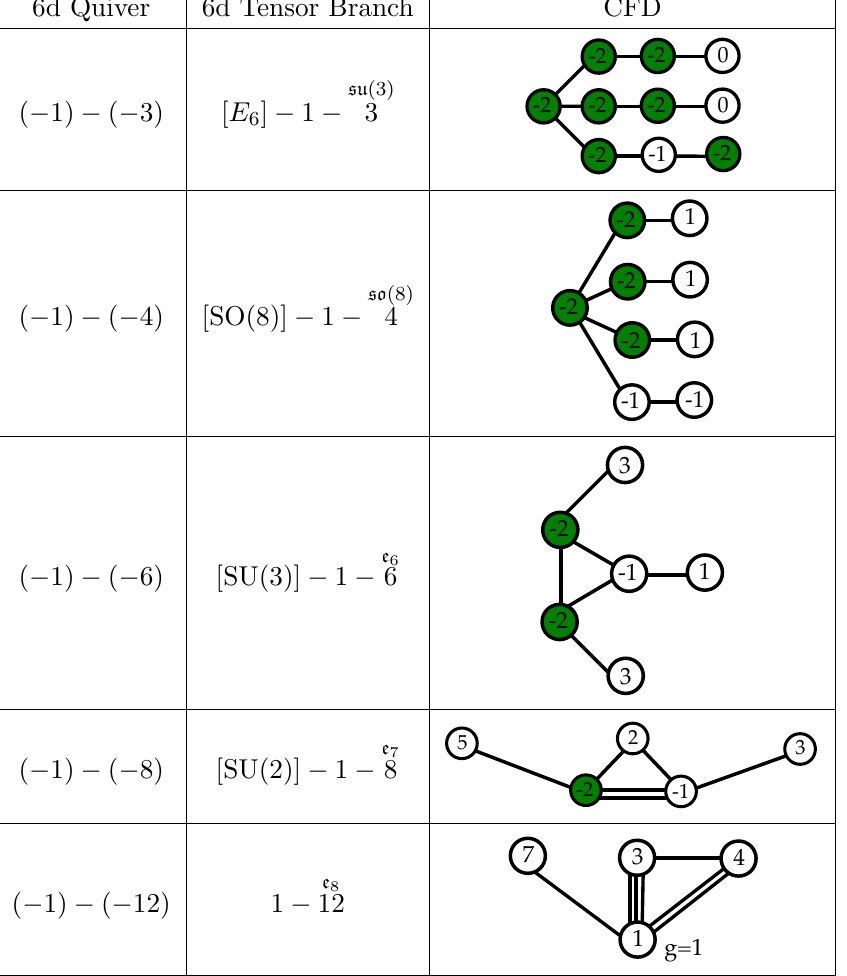
Table 7. CFDs for 5d theories obtained by reduction from 6d quivers with two nodes ( (cid:0) 1) (cid:0) ( (cid:0) n ), where ( (cid:0) n ) corresponds to an NHC. The tensor branch geometry is shown in the middle and the CFDs in the right-most